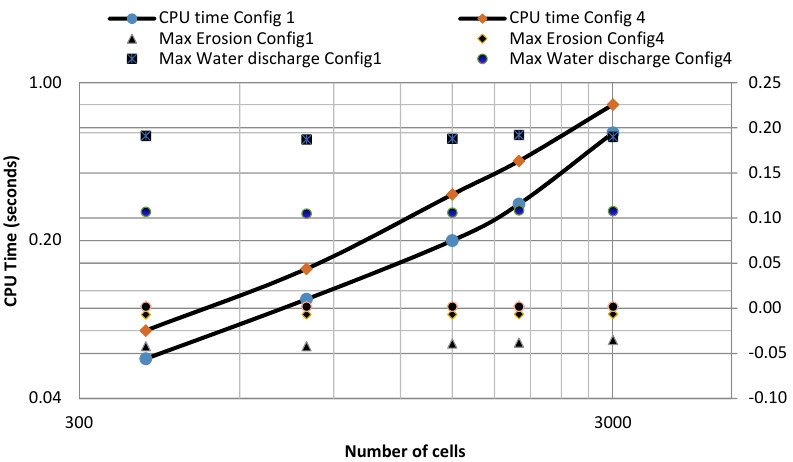
Figure 9. CPU-time performance and Sensitivity of hydraulic and morphologic parameters to mesh refinement. Sensitivity of the sediment parameters, including Manning’s roughness ( n ) and porosity (p) are